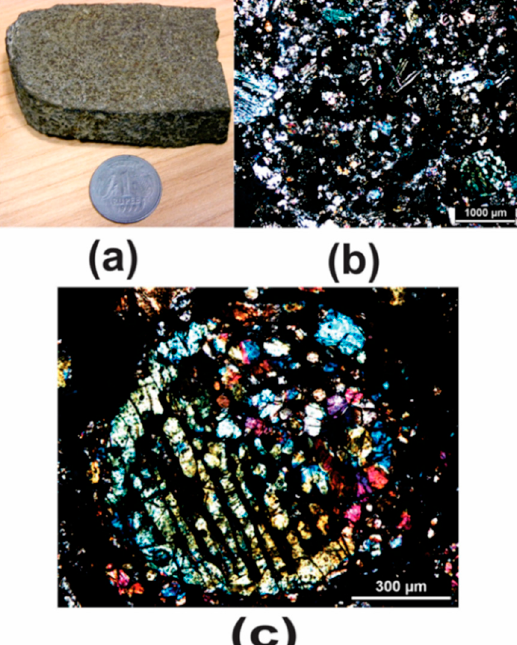
Figure 5. (a) Photograph of the Dergaon fall meteorite sample. (b) Photomicrograph of the Dergaon meteorite showing chondrules of various types and exhibiting porphyritic texture under crossed polarizers (c) A barred olivine chondrule from the Dergaon meteorite showing the olivine bars and a single rim in optical continuity. The glass phase is optically isotropic under crossed polarizers. Metallic phases are optically opaque.